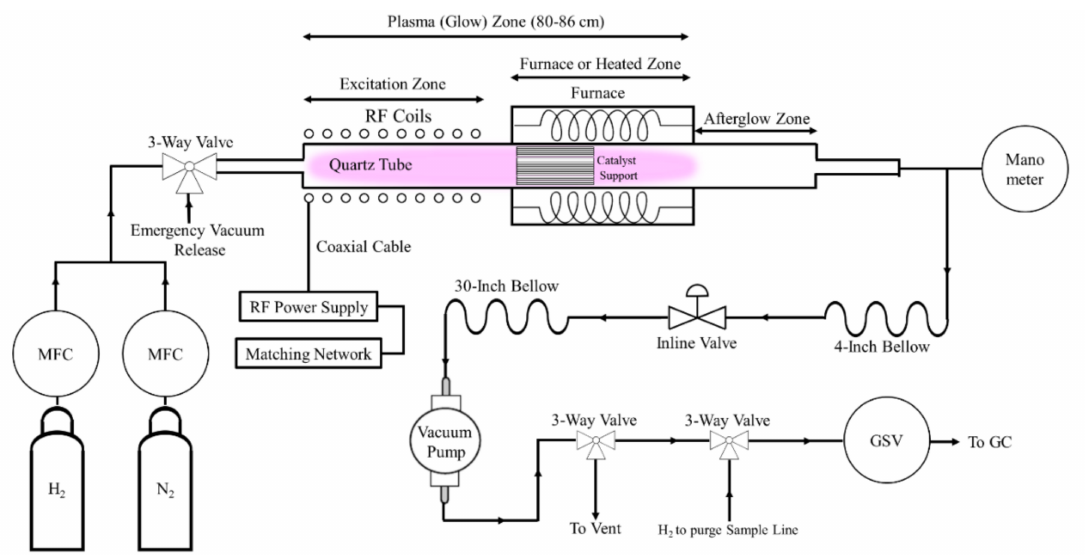
Figure S1: Ammonia Yield (%) vs. Time (min) for reactions run with no catalyst title, Figure S2: Ammonia Yield (%) vs. Time (min) for reactions with pure In as catalyst, Figure S3: Ammonia Yield (%) vs. Time (min) for reactions run with Ga-In Alloy (20:80), Figure S4: Ammonia Yield (%) vs. Time (min) for reactions run with Ga-In Alloy (40:60), Figure S5: Ammonia Yield (%) vs. Time (min) for reactions run with Ga–In Alloy (50:50), Figure S6: Ammonia Yield (%) vs. Time (min) for reactions run with Ga-In Alloy (60:40), Figure S7: Ammonia Yield (%) vs. Time (min) for reactions run with Ga:In Alloy (80:20), Figure S8: Ammonia Yield (%) vs. Time (min) for reactions run with pure Ga as catalyst, Figure S9: Ga-In Alloy Phase diagram, Figure S10: Ammonia Yield (%) vs. Alloy Melting Point ( ◦ C) for various plasma powers, Figure S11: Energy Yield (g-NH3/kWh) vs. Composition of Alloy (mass%) for various plasma powers, Figure S12: Formation of GaN (plasma treatment time), (a) Starting of